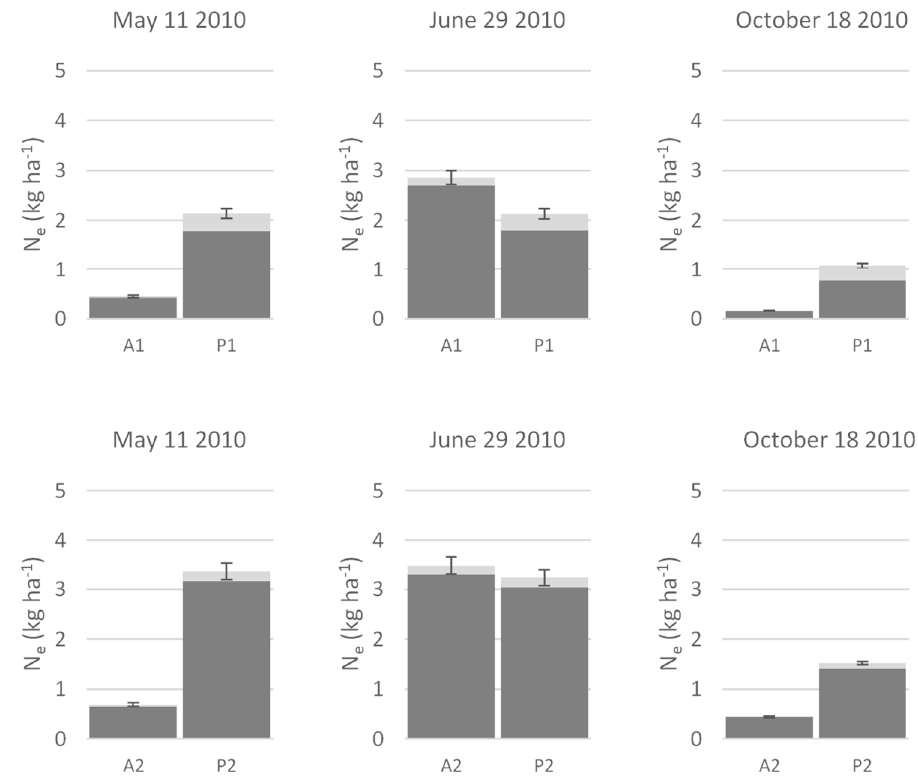
Figure 3. N emissions from A1, A2, P1 and P2 plots; in each column, dark gray is NH 3 , light gray is N 2 O (bars represent standard errors for each column). All the mean values are significantly different from each other (Tukey’s HSD, * p < 0.05).